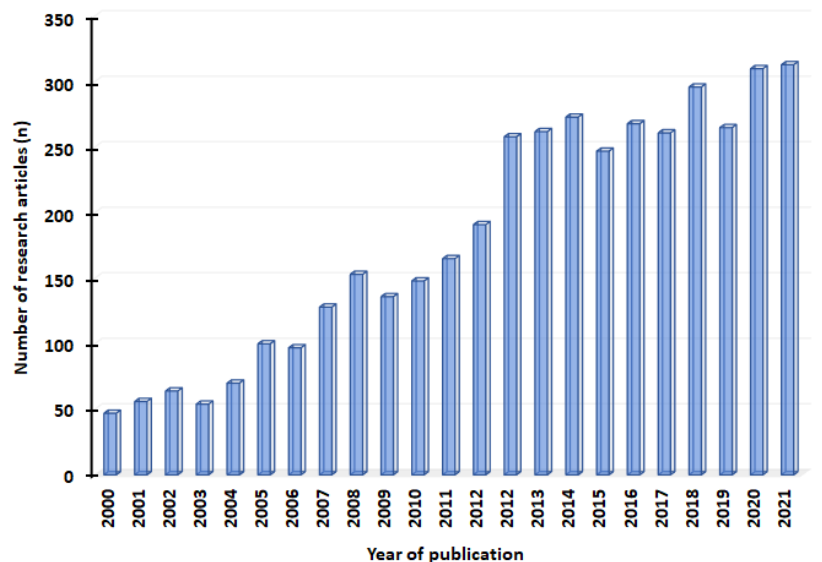
Figure 1. The number of articles published in the treatment of neuropathic pain from 2000 to